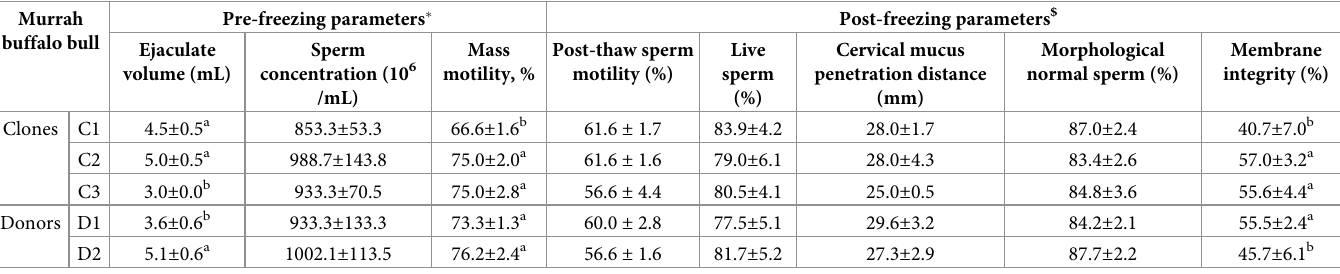
Table 1. Semen parameters of cloned buffalo bulls and